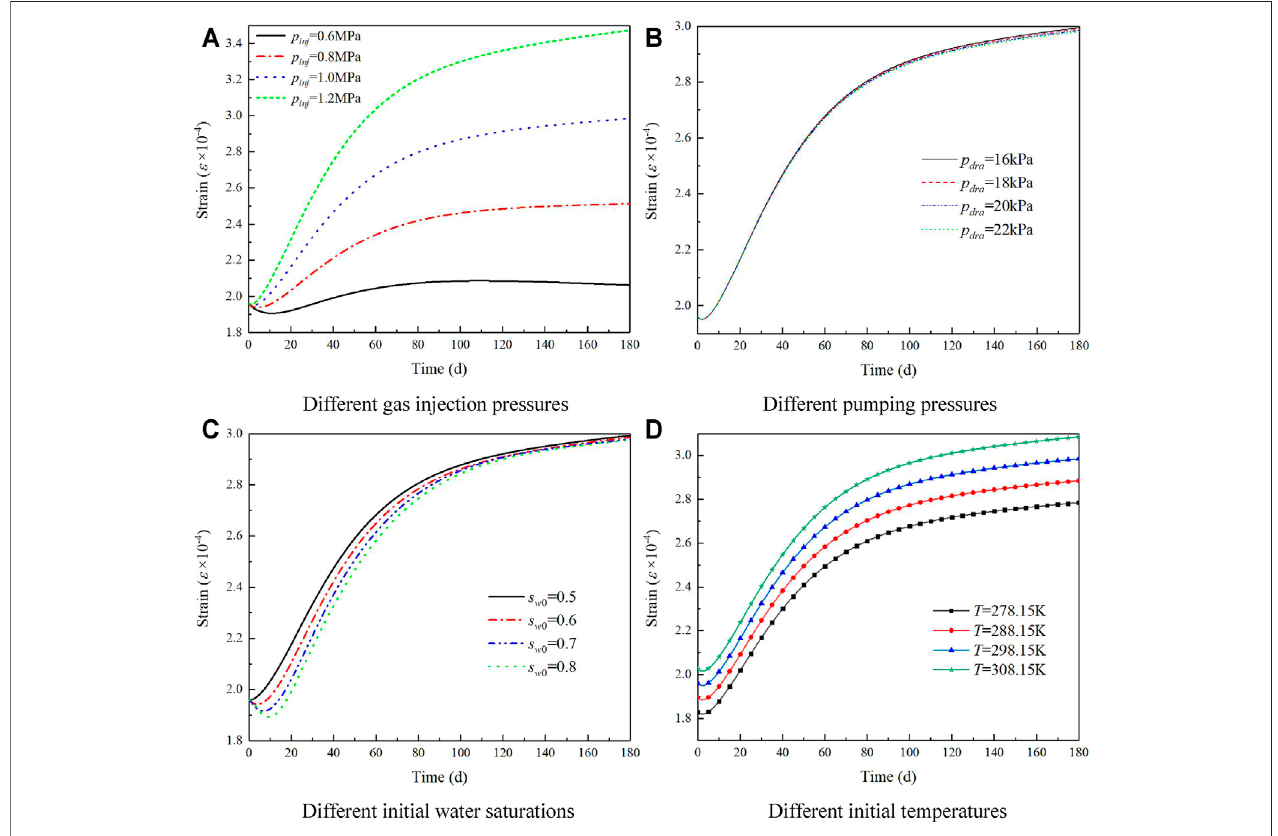
FIGURE 7 | Evolution of coal skeleton strain on point D under different parameters during CO 2 enhanced gas drainage. (A) Different gas injection pressures. (B) Different pumping pressures. (C) Different initial water saturations. (D) Different initial temperatures.